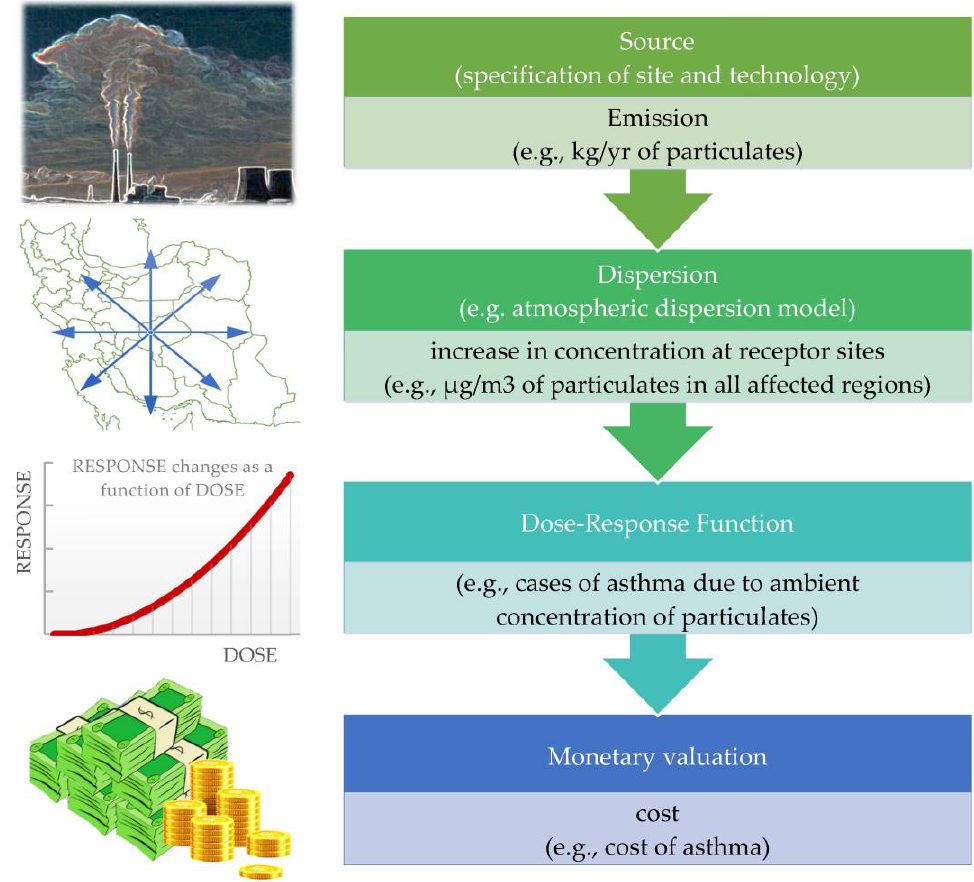
Figure 1. The principle impacts pathway approach steps for assessing air pollution. Source: Based on [15].